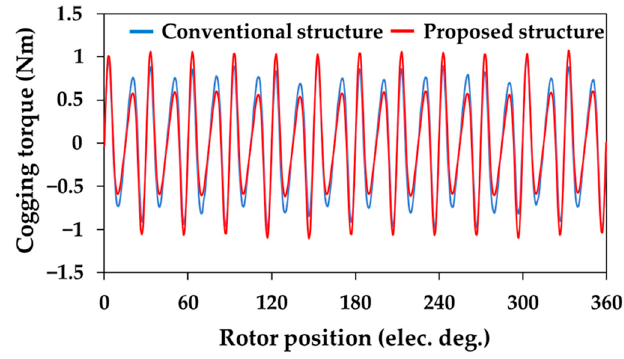
Figure 6. ( a ) Open-circuit phase back-EMF waveforms and ( b ) its spectrum.